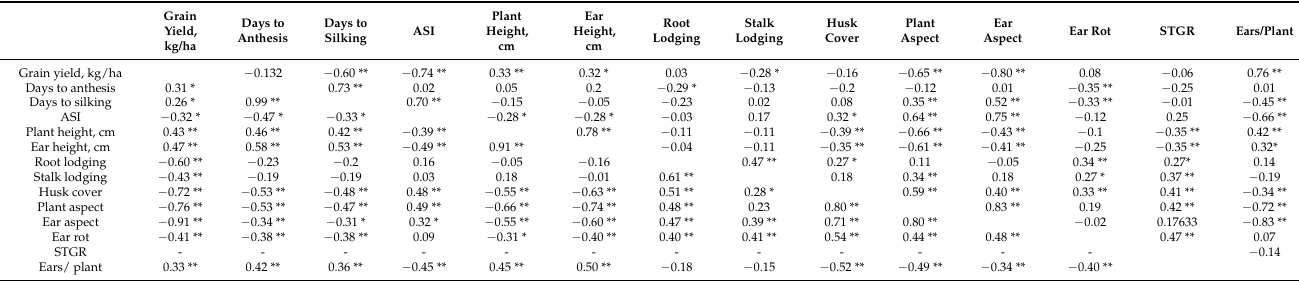
Table 5. Correlation coefficients of grain yield and other agronomic traits of extra-early maize hybrids of three breeding eras evaluated in 3 locations under drought (upper diagonal) and six locations under rainfed (lower diagonal) conditions between 2016 and 2019 in Nigeria.